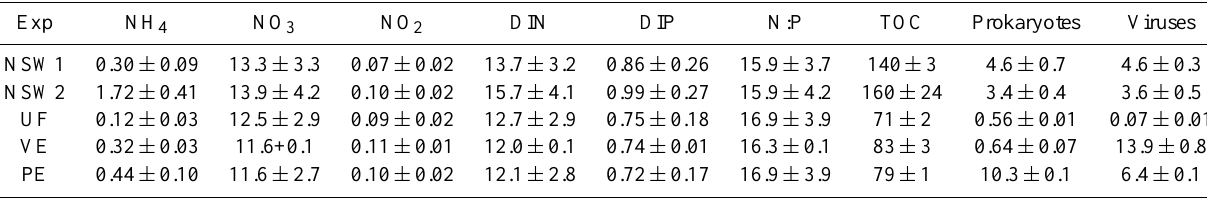
Table 2. Nutrient concentrations and prokaryotic and viral abundance in incubation water at the start of the experiments. Nutrient and TOC parameters are given in µM, prokaryotes as 10 5 cellsml − 1 and viruses as 10 6 viruses ml − 1 . Data are given as averages ± SE of 3 replicates. Exp, experiment; NSW, natural sea water; UF, ultrafiltrate; VE, virus-enriched; PE, prokaryote-enriched; DIN, dissolved inorganic nitrogen; DIP, dissolved inorganic phosphorus.